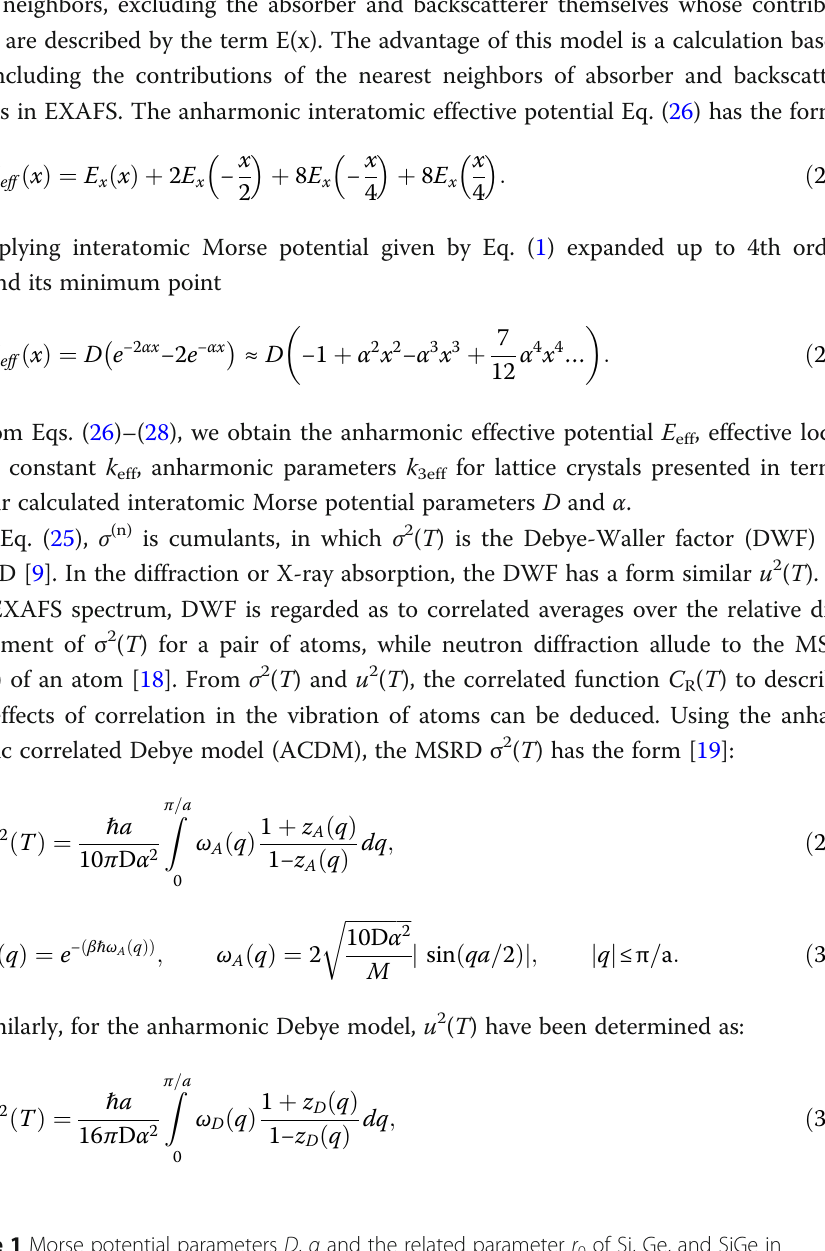
Table 1 Morse potential parameters D , α and the related parameter r 0 of Si, Ge, and SiGe in comparison to some experimental results [10, 14]